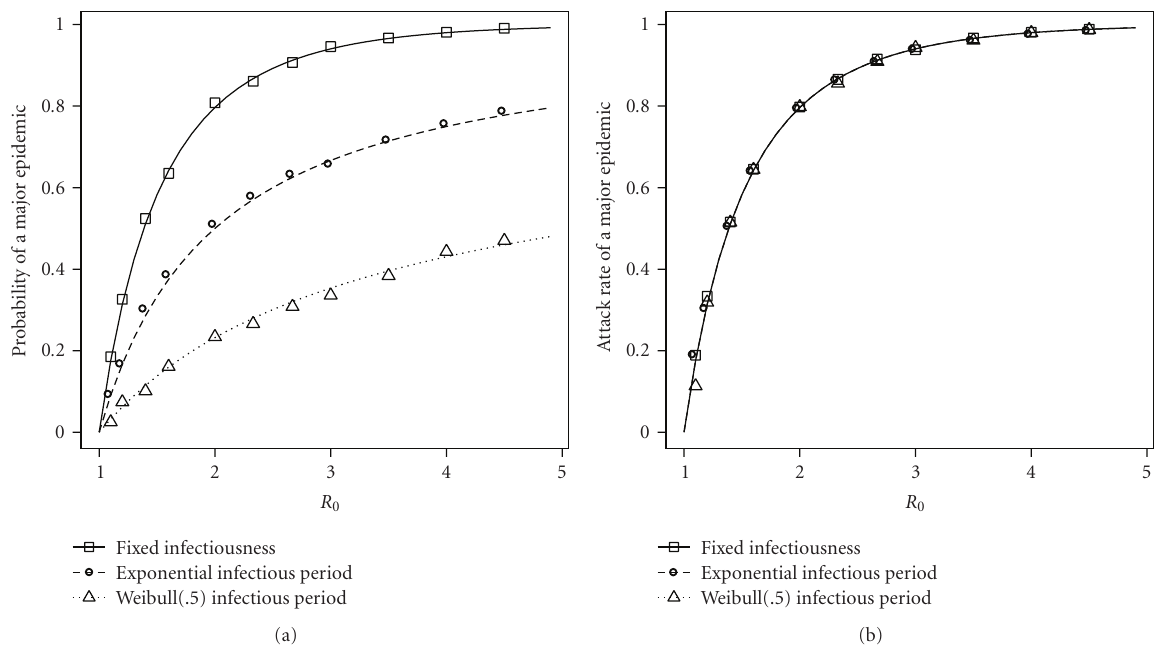
Figure 2: Major epidemic probabilities and attack rates in the mass-action models from Section 3.1. Lines represent theoretical predictions based on EPNs, and symbols represent observed probabilities and attack rates in simulations. The observed probability of a major epidemic is based on 1,000 runs of each model, where a major epidemic was defined as an epidemic with a final size ≥ 250. The observed attack rate is based on a single major epidemic. All models have a population of size 50,000. The predicted probability and attack rate of a major epidemic are equal only when the infectious period is